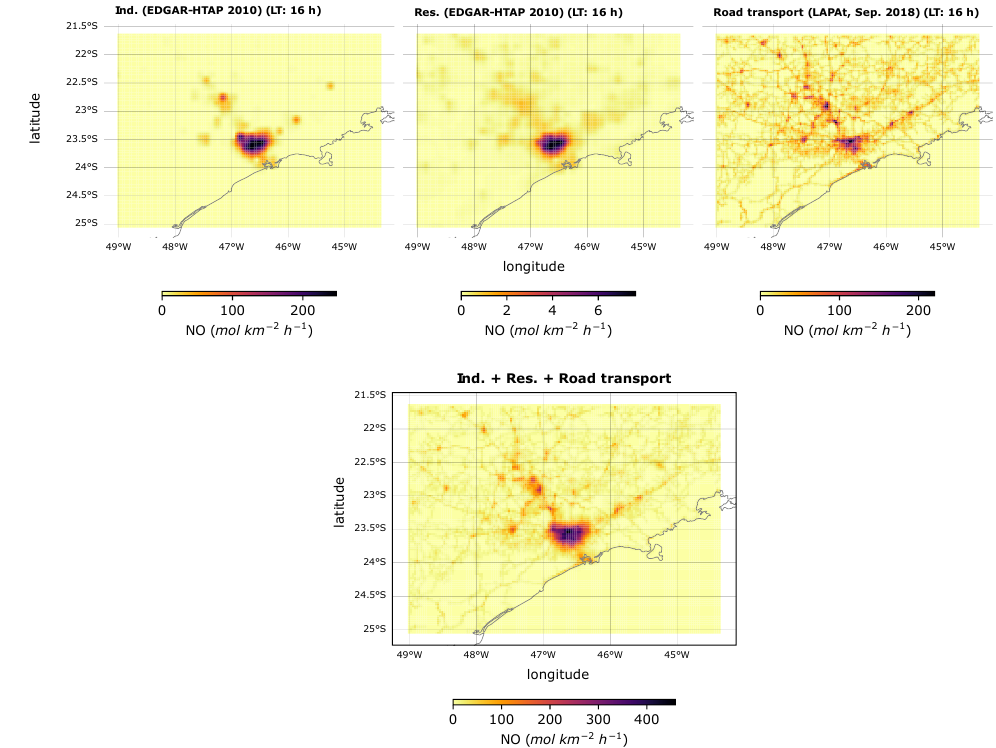
Figure 2. Sum of anthropogenic NO emissions as input to the WRF-Chem model for the second 3 km horizontal resolution